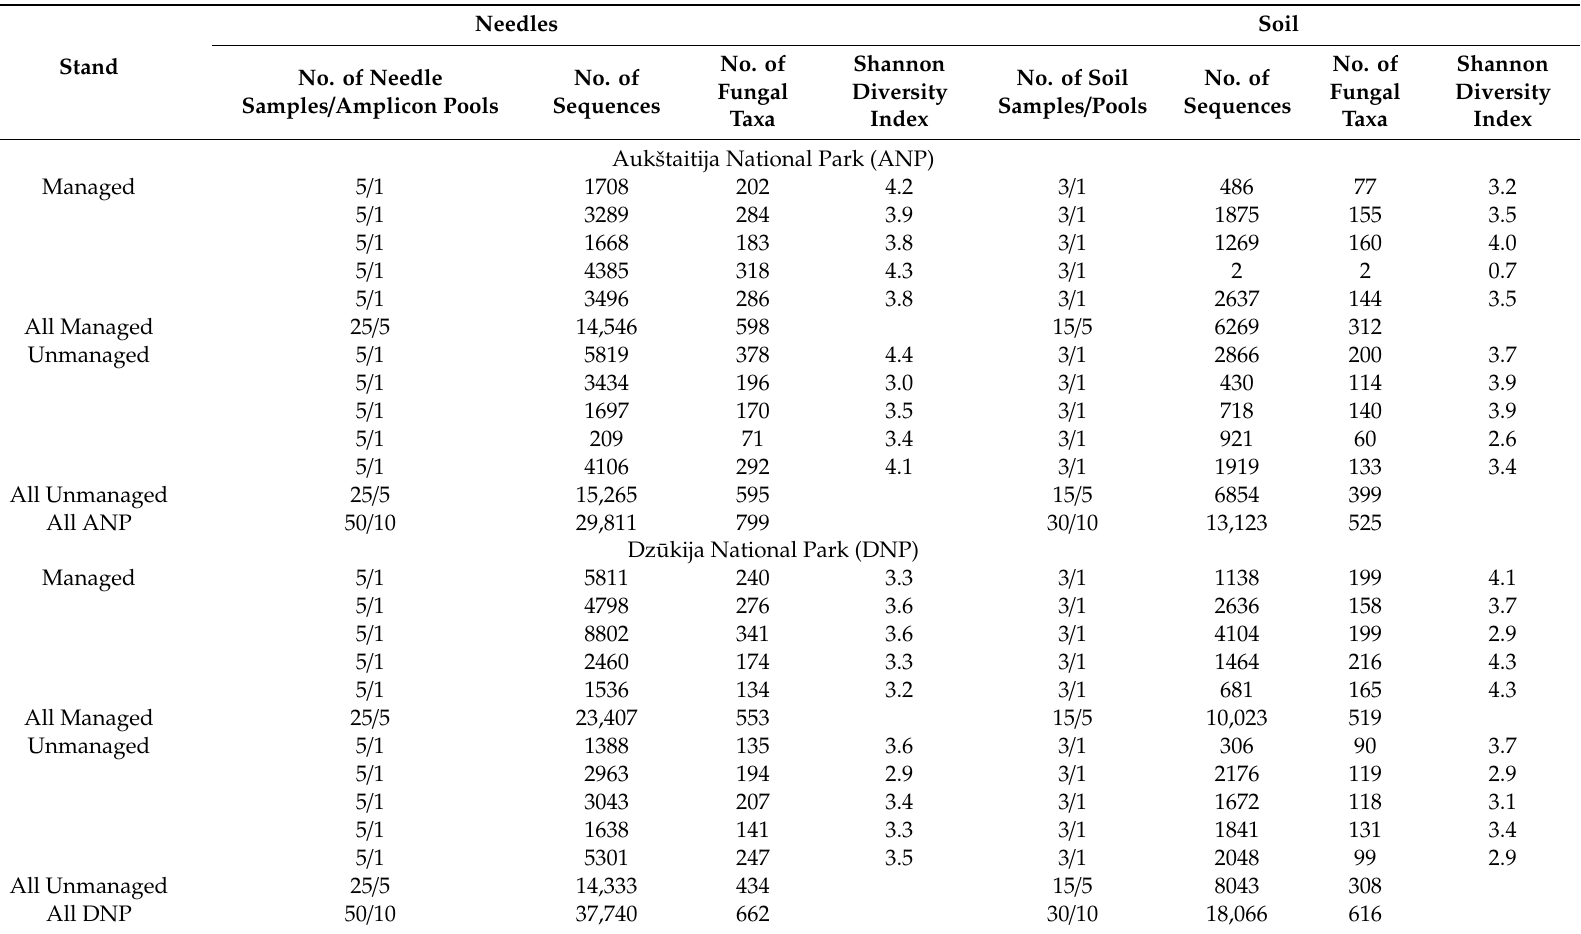
Table 2. Sampled needles and soil of Pinus sylvestris in managed and unmanaged forest stands, generated high-quality ITS2 rRNA fungal sequences, and detected diversity of fungal taxa.